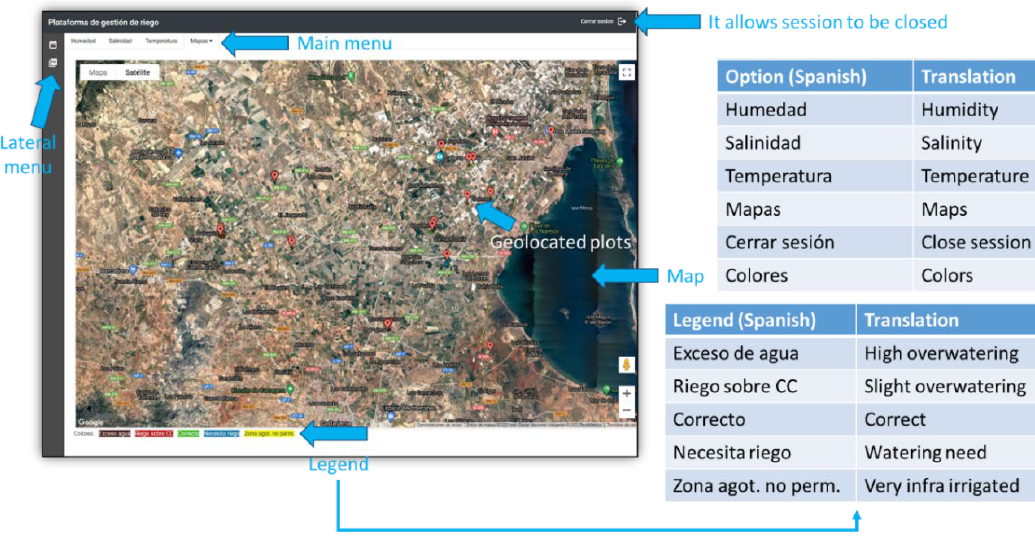
Figure 4. Main screen of the Irriman Platform WEB application. As it is used by farmers and other stakeholders in Spain, text captions are written in Spanish. The translation is shown for the menu options and for the legend that describes how plots are being watered.